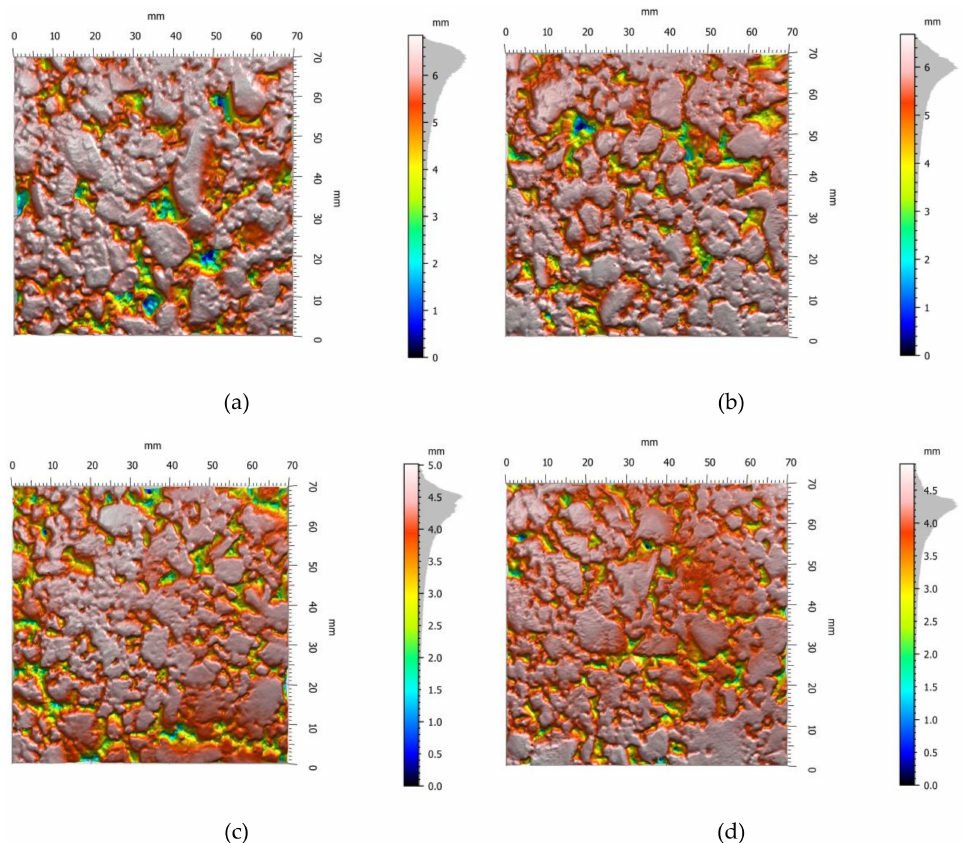
Figure 7. Reconstructed 3D surfaces topography. ( a ) Pavement in the field; ( b ) rutting slabs (RS)-97; ( c ) RS-100; and ( d )